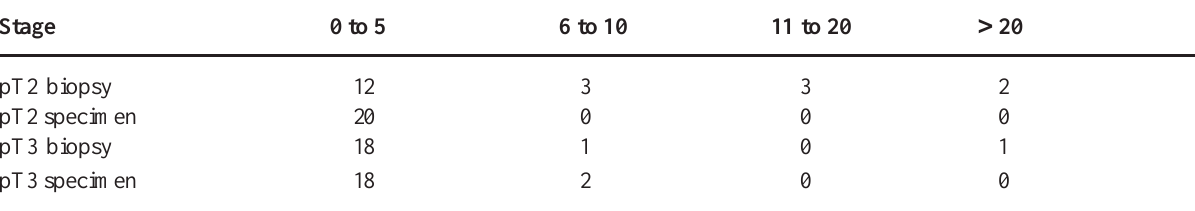
Table 4 – Number of patients that present p53 nuclear expression in the biopsy and in the surgical specimen, in stages (pT2 and pT3). The columns refer to the percentage of cells with expression.